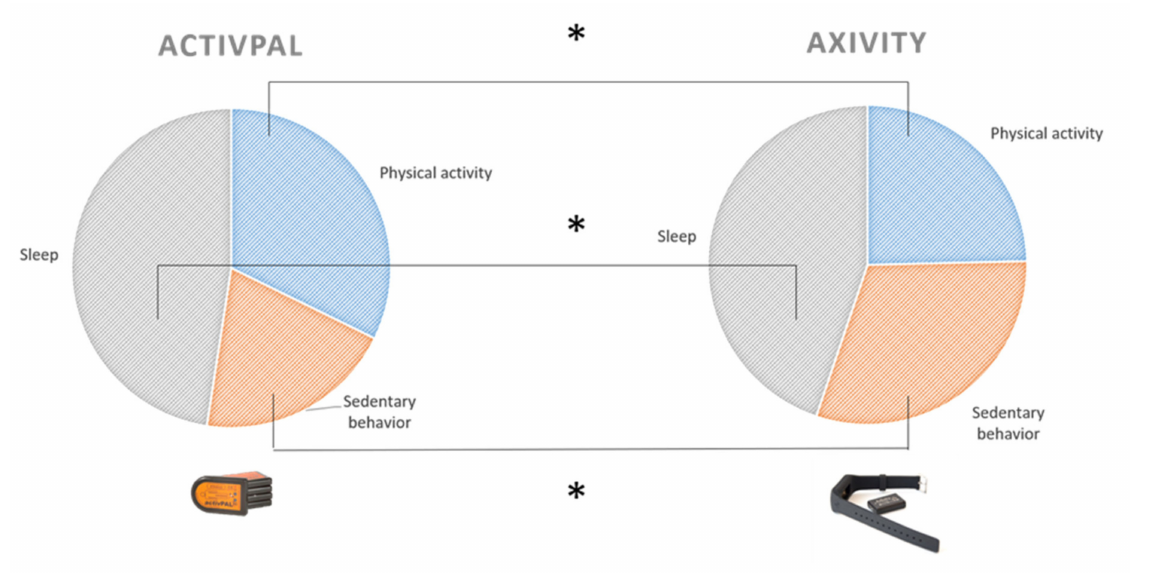
Figure 1. Visual representation of the distribution of time in physical activity, sedentary behavior and sleep across 24 h measured with the ActivPAL on the one hand and the Axivity on the other hand. * Significant difference between ActivPAL and Axivity accelerometer ( p <